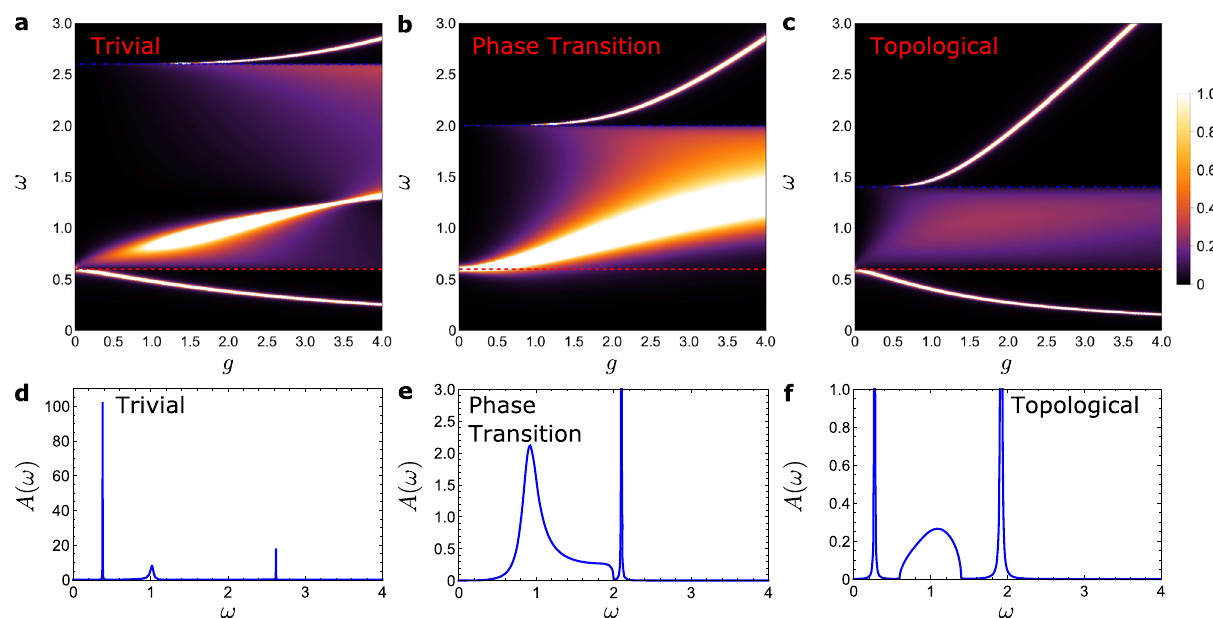
Fig. 5 Photon spectral function. a – c Spectral function A ( ω ) (amplitude normalized by its maximum value is given by the color bar) as a function of the light-matter coupling g and frequency ω . Red dashed line corresponds to frequency ω c and blue dot-dashed line corresponds to 2 E ( k = π ). a Trivial phase: intracell hopping v = 0.8 and intercell hopping w = 0.5. There are three polariton branches. b The gap at k = 0 closes for v = w = 0.5 corresponding to the topological phase transition. There are only two polariton branches. c Topological phase, v = 0.2, w = 0.5. There are three polariton branches. The photon frequency ω c is chosen such that ω c = 2 E ( k = 0) [for v ≠ w ]. Other parameters are fi xed as ω c = 0.6 and η = 10 − 3 . d - f Spectral function A ( ω ) as a function of ω for g = 2. d There are three peaks. e There are two peaks. f There are three peaks. The lower polariton branch is absent at the topological phase transition ffiffiffiffiffiffiffiffiffiffiffiffiffiffiffiffiffiffiffiffiffiffiffiffiffiffi p ω 2 (cid:2) 2 ω g 2 w . In agreement with c c